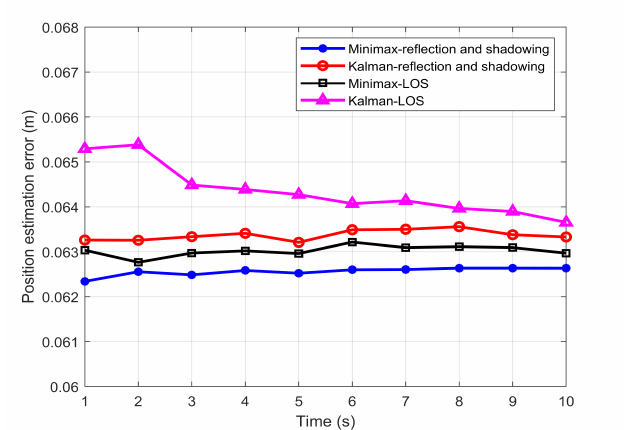
Figure 6. Position estimation error of the minimax verses the Kalman filters using line of sight (LOS) and shadowing.